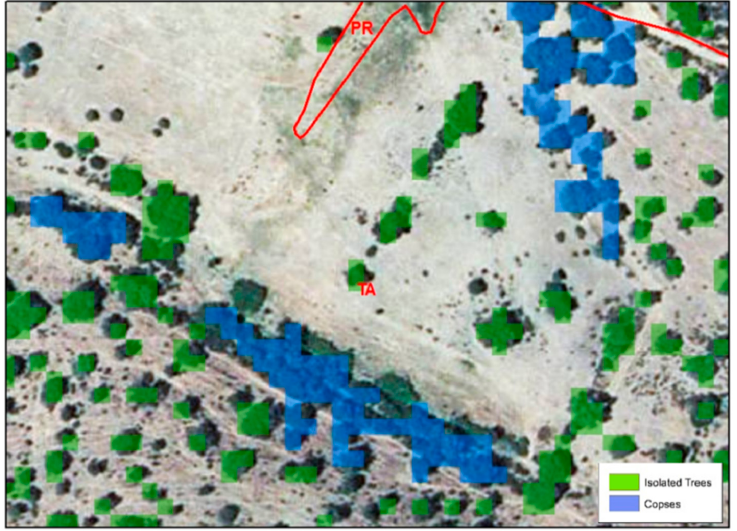
Figure 15. Identification of isolated trees and copses. Isolated trees are represented in green color, and copses are in blue areas.